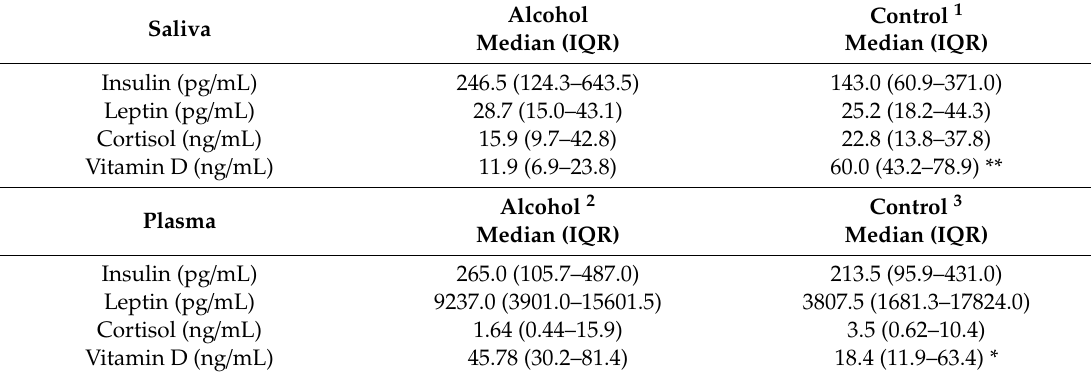
Table 5. Concentrations of cortisol, insulin, leptin, and vitamin-D in the saliva and plasma of the alcohol and control groups.